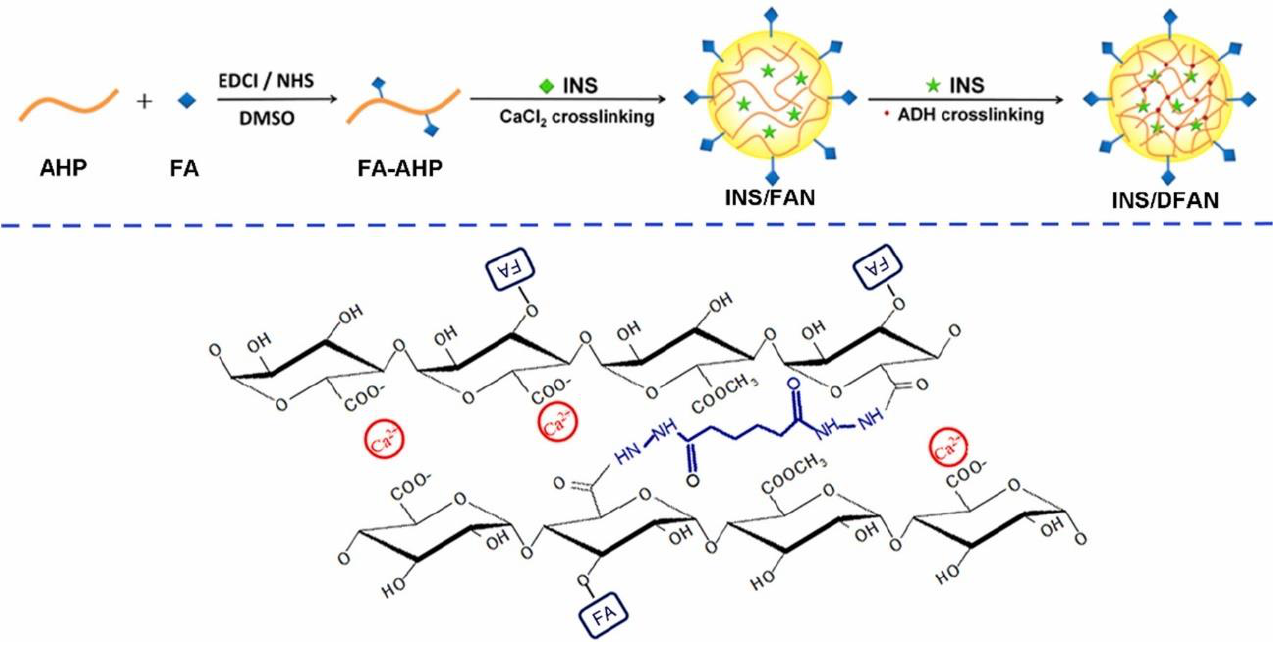
Figure 5. Synthesis structure of INS/DFAN dual-crosslinked. Adapted from Zhang et al. [39].